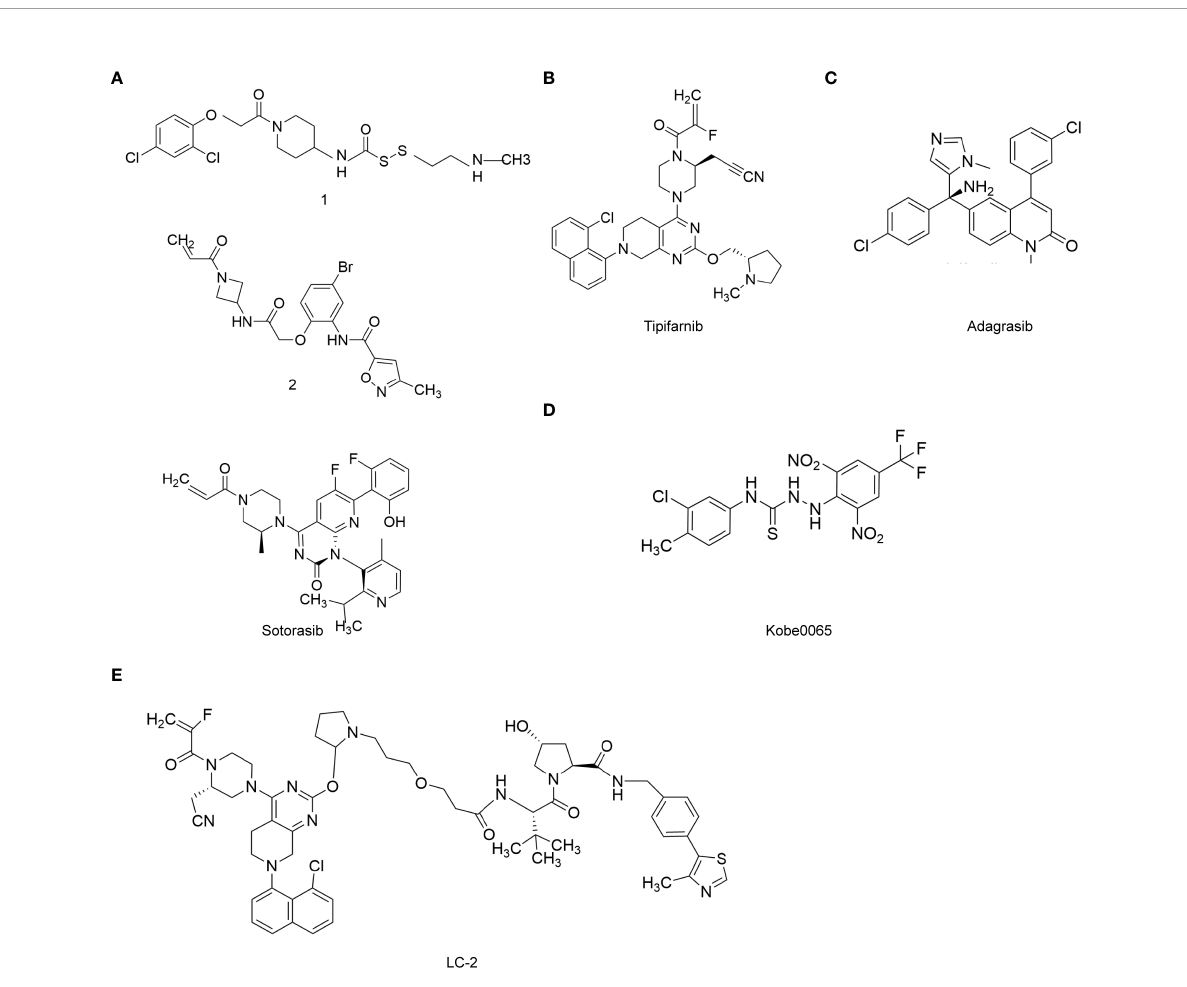
FIGURE 3 RAS target-related chemotherapy drugs. (A) , Sotorasib; (B) , Tipifarnib; (C) , Adagrasib; (D) , Kobe0065; (E) , PROTAC